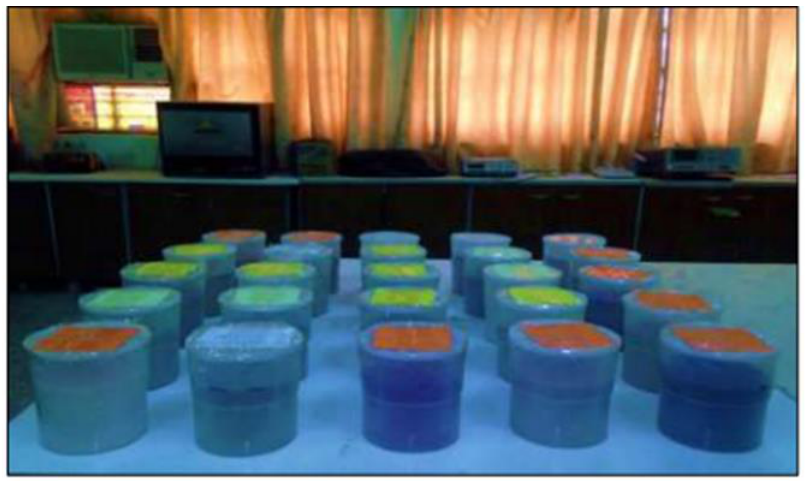
Figure 1. Samples inside the Marinelli